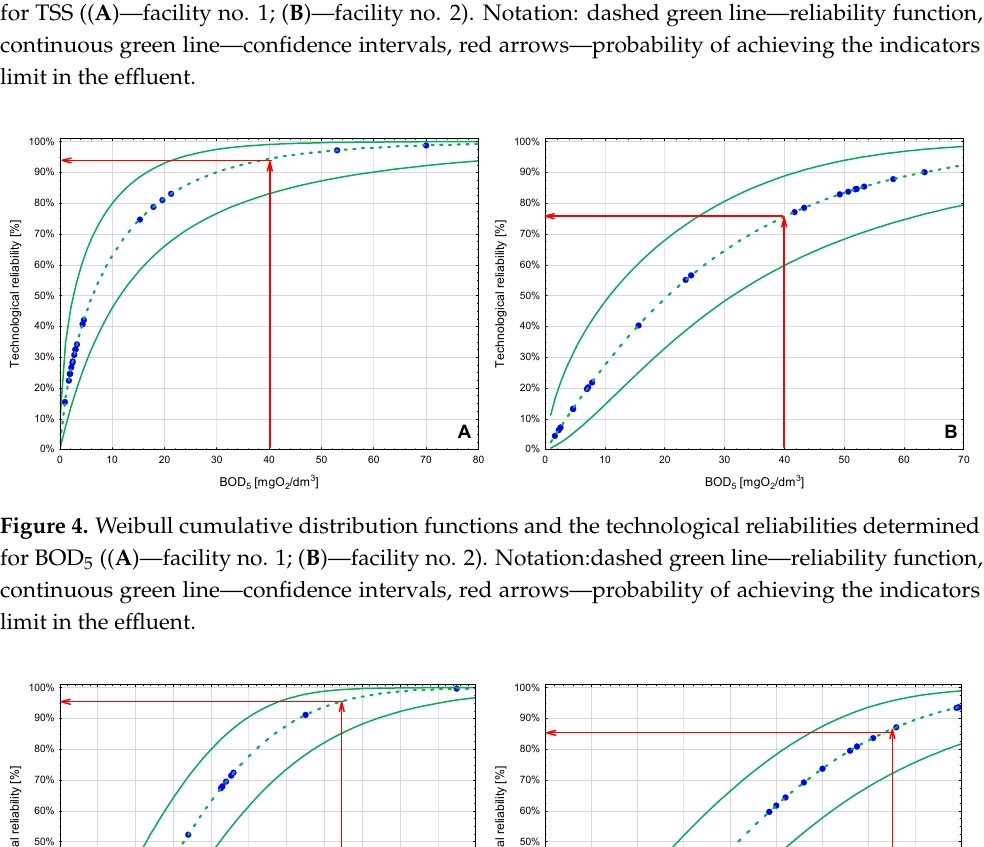
Figure 5. Weibull cumulative distribution functions and the technological reliabilities determined for COD (( A )—facility no. 1; ( B )—facility no. 2). Notation : dashed green line—reliability function, continuous green line—confidence intervals, red arrows—probability of achieving the indicators limit in the effluent. The reliability indicators obtained in the analyzed activated sludge facilities in the RPN for COD are comparable to those obtained by Bugajski et al. [59] in a household WWTP working in activated sludge technology. At the same time, in the facilities in the RPN, the reliability of COD removal was higher than that found in a treatment plant based on an identical tank design but without a preliminary settling tank (60%) [32]. The relia- bility of COD removal in a small SBBR was 97.8% [35]. However, similarly to the case of BOD 5 , maximum (100%) COD removal reliability was reported in two other household hybrid CWs WWTPs operating in the RNP [36]. Moreover, Marzec et al. [33] achieved